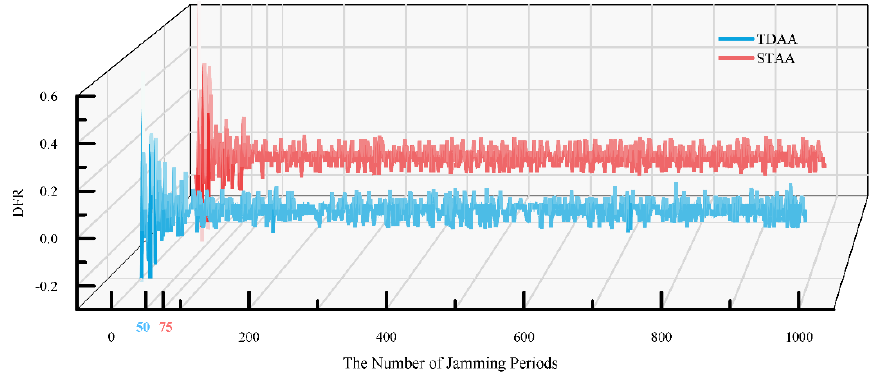
Figure 7. Schematic diagram comparing the DFR between the TDAA [11] and the STAA.